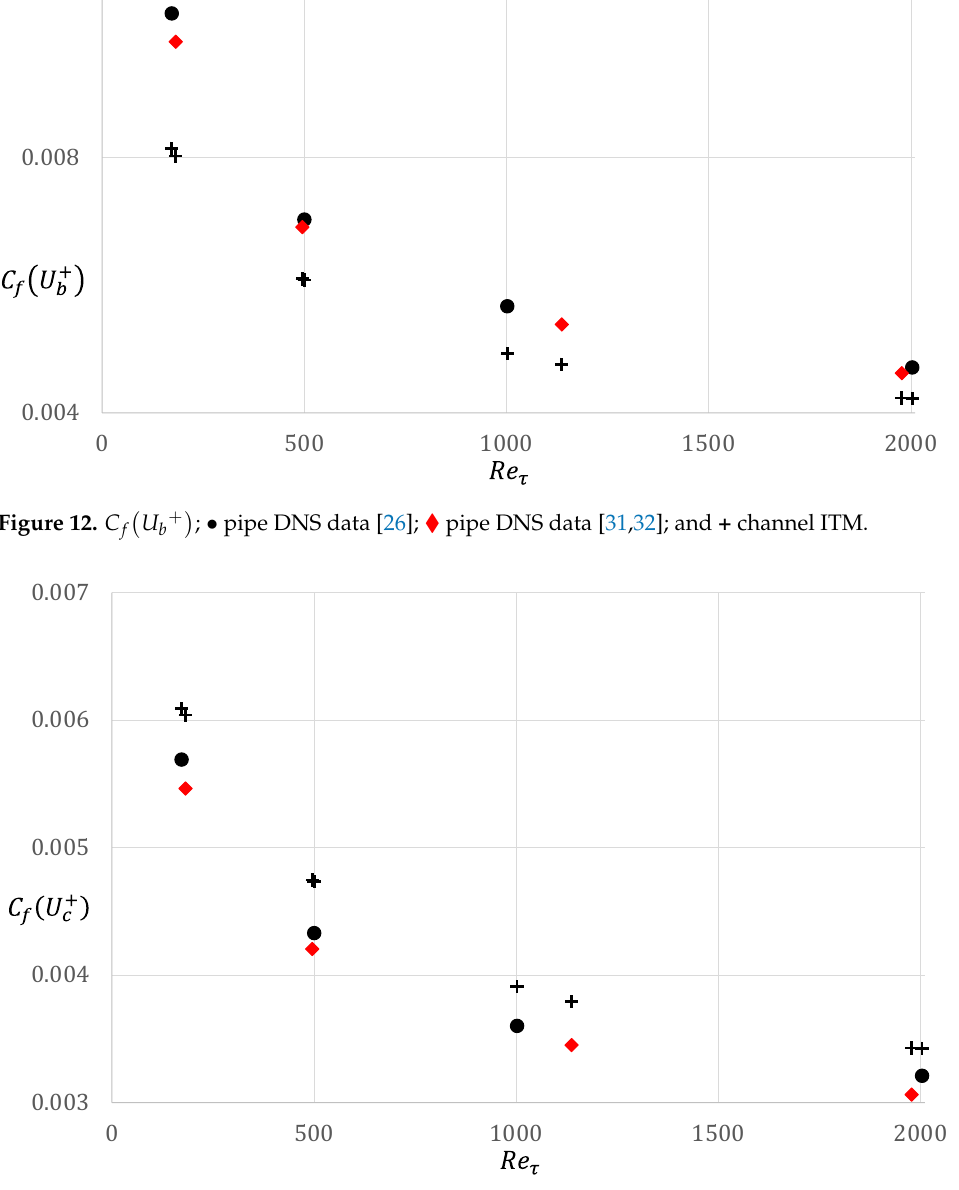
Figure 13. Trend of the skin friction C f channel